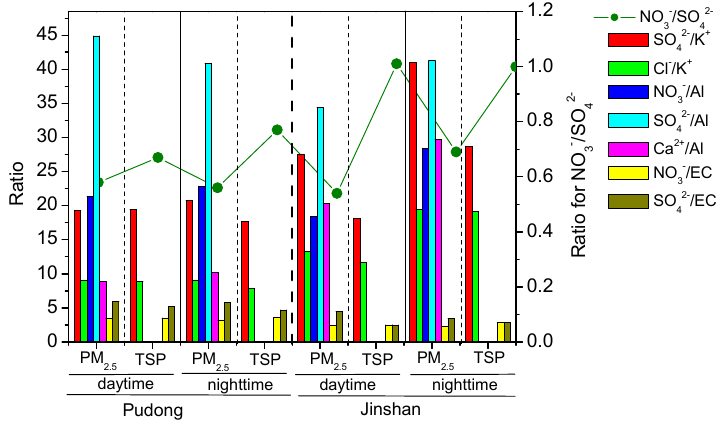
Figure 6. The variations of chemical species ratios in